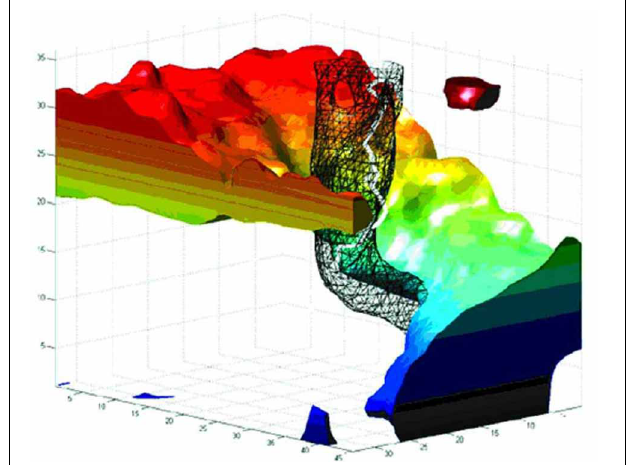
FIGURE 1 | The evolution of a spiral wave over one rotational orbit. Space is represented in the horizontal axes, and time (in milliseconds) on the vertical axis. The black mesh encloses a thresholded area of reduced variance (i.e., low amplitude) at the spiral center, as observed in cortex by Huang et al. (2004, 2010). The white tube within the black mesh tracks the evolution of the phase singularity at the spiral core. Note the fast (80–90 Hz ) oscillation of the singularity, which we hypothesize underlies the fast component of fixational tremor. Reproduced from Figure 8B in Bray et al. (2001), copyright John Wiley and Sons Publishing